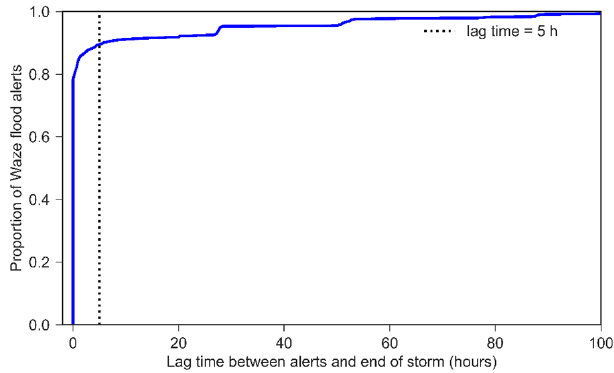
Figure 10. Distribution of delay in alert posting from storm